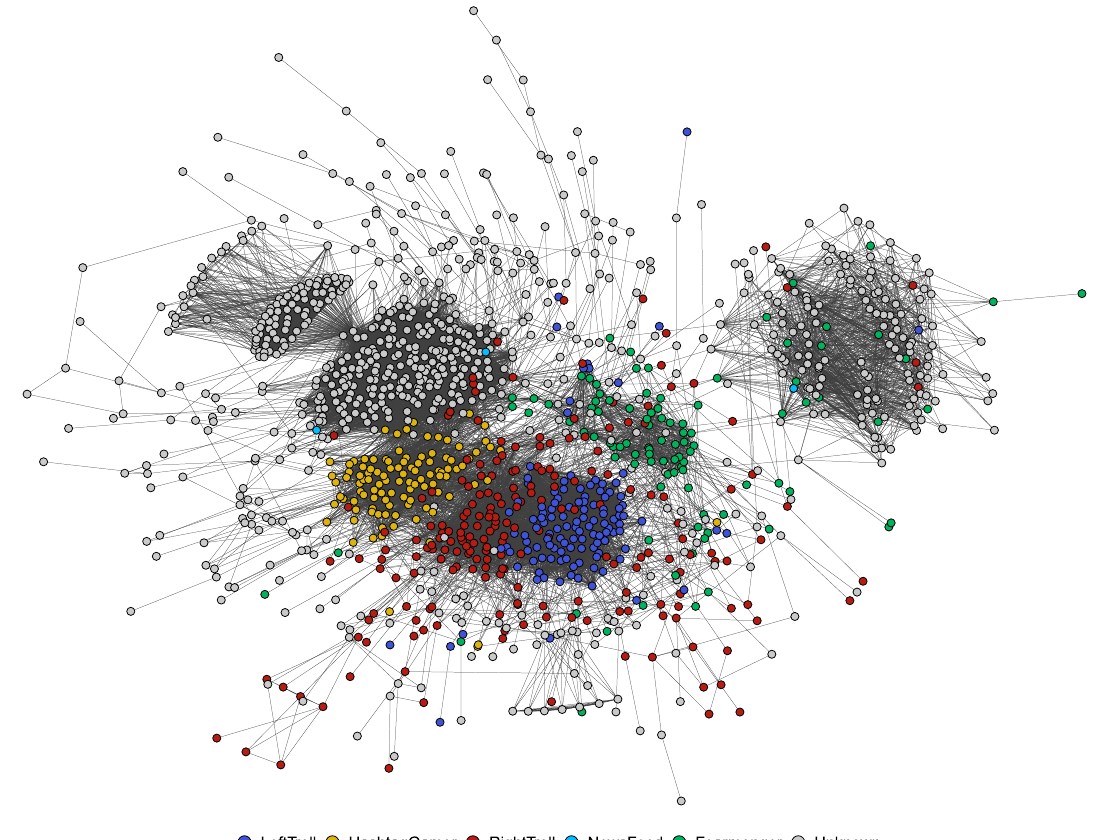
Figure 3. Astroturfing campaigns that target diverse audiences (here: Black Lives Matter activists in blue and Trump Republicans in red) are still connected in a message coordination network. Combined co-tweet and co-retweet network among IRA accounts that tweet in English. Node color is taken from a typology of Linvill and Warren, who manually classified IRA accounts according to their content 29